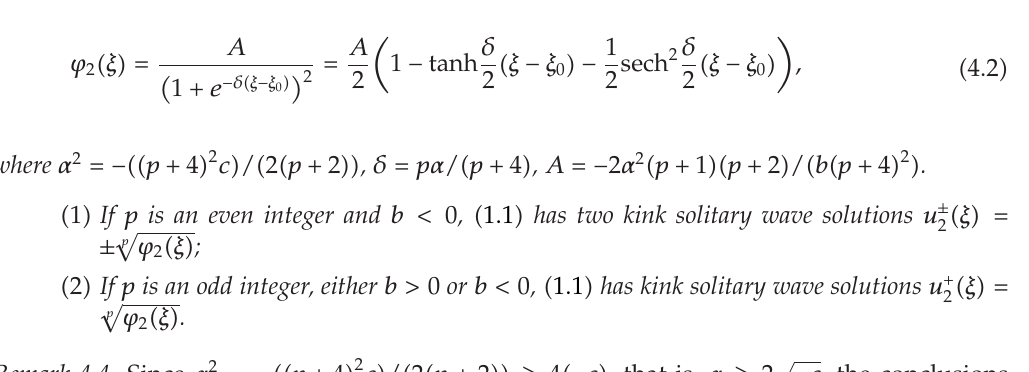
Figure 10 when b < 0 and corresponds to the heteroclinic orbit L (cid:6) P 0 , P 1 (cid:7) in Figure 12 (cid:6) a (cid:7) when b >